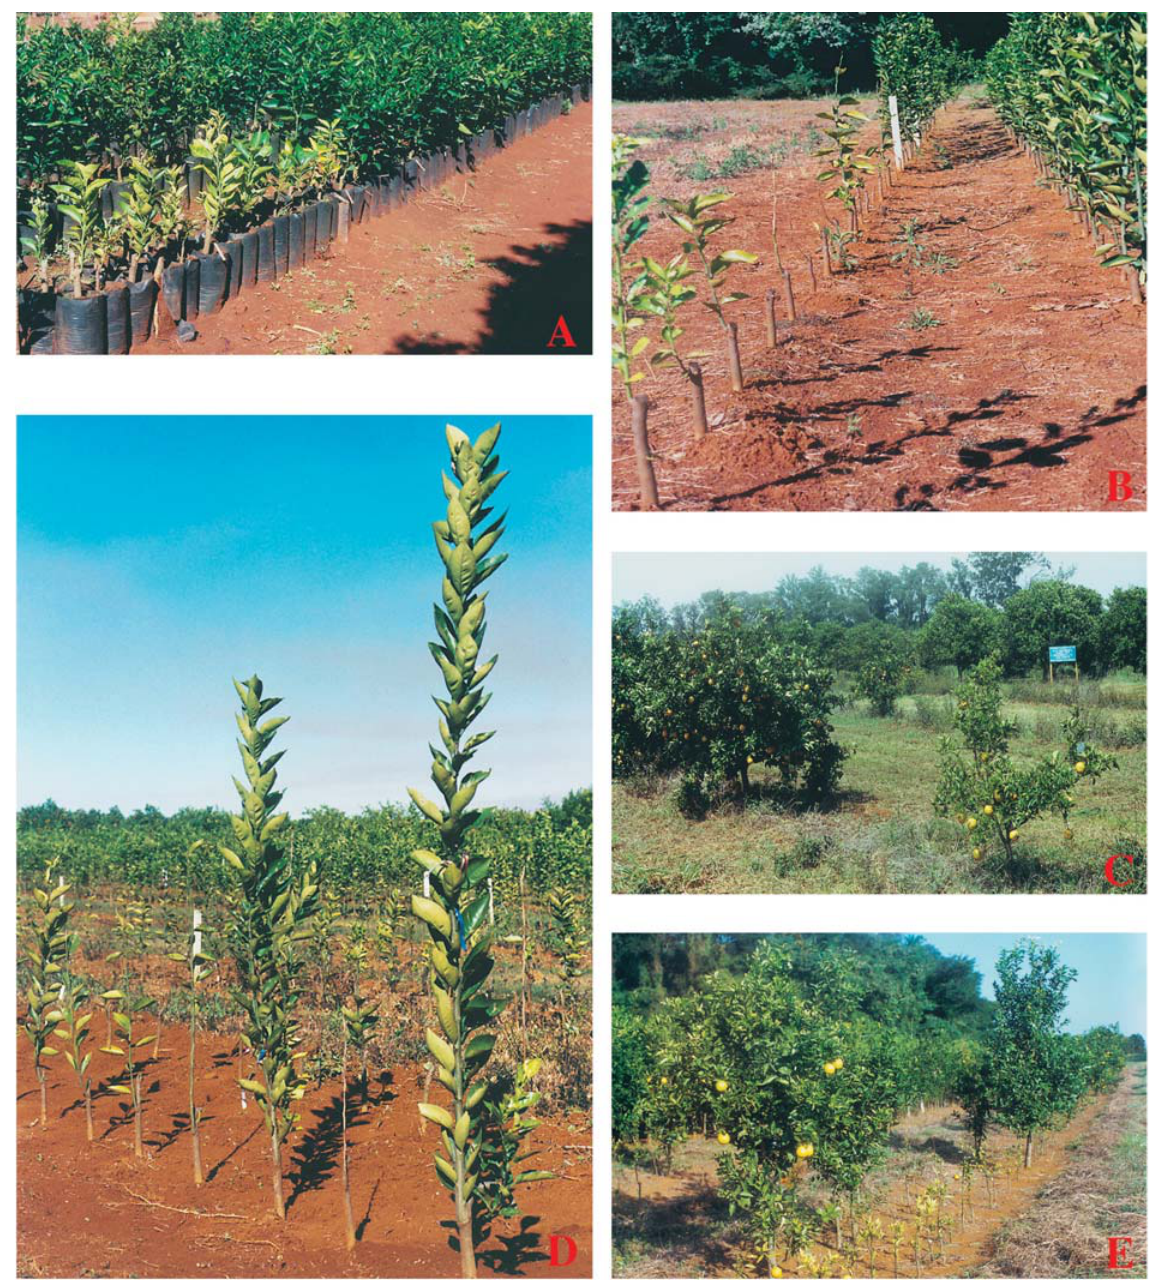
Figure1 -ValenciaorangescionsgraftedontoAzeda(intolerant)inthenurserybeforetransplantingtotheCOSIplot(A)andintheplotCOSII(B).The plants on the left show extreme symptoms of intolerance to tristeza (seedling yellows - score 7) when compared with tolerant plants (scores 1 and 2). When grafted onto segregating hybrids in COS I (C) and COS II (D and E), there was a conspicuous reduction in plant vigor in the intolerant